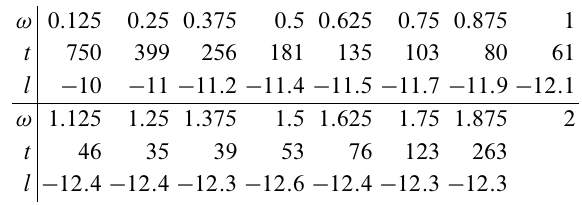
Table 3. SOR: numbers of iterations for tested ! .